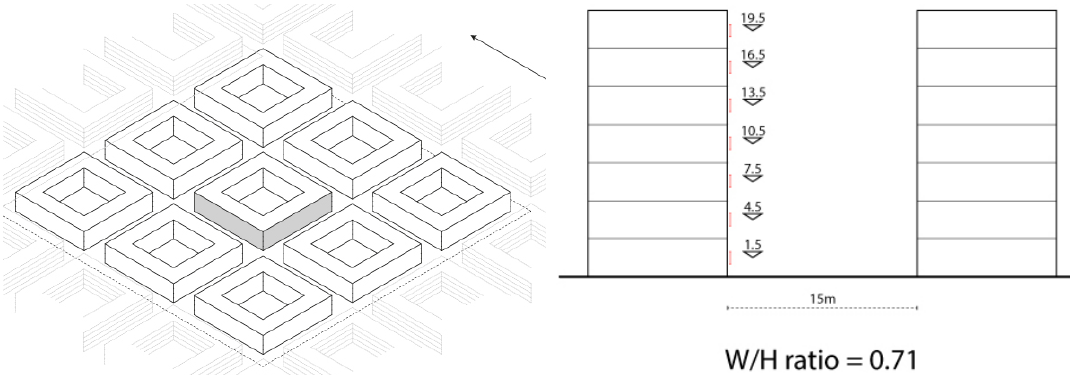
Figure 4. The analysed façades and section of the analysed urban